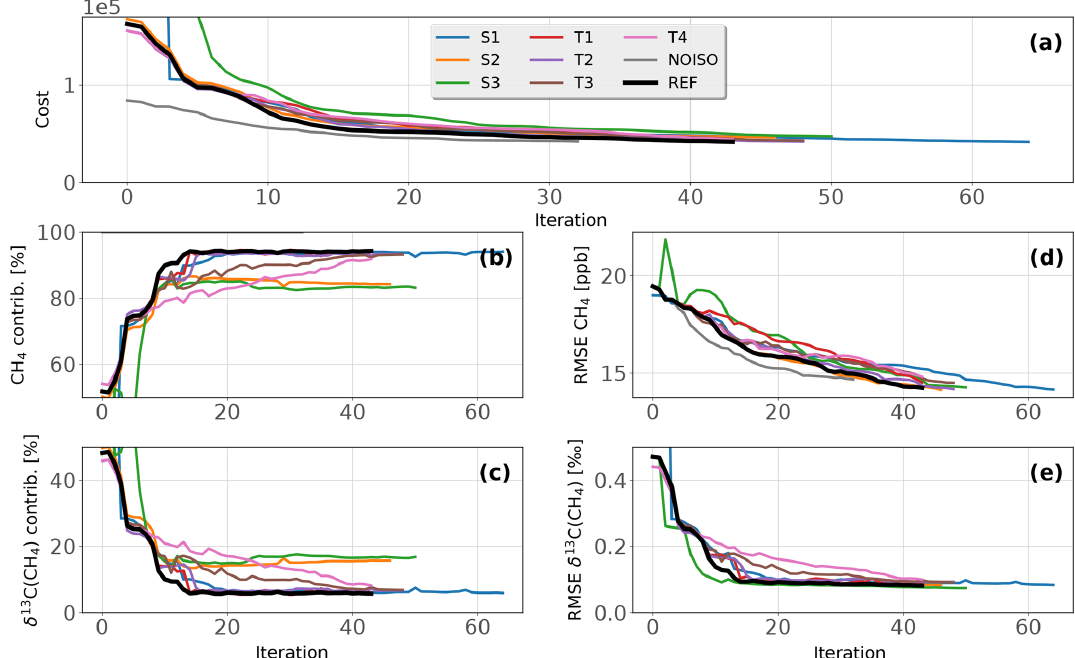
Figure 3. Minimization of the cost function for all configurations. (a) Value of the cost function with respect to the number of iterations. (b) CH 4 contribution to J o . (c) δ 13 C ( CH 4 ) contribution to J o . (d) RMSE associated to observed–simulated CH 4 . (e) RMSE associated to observed–simulated δ 13 C ( CH 4 ) . For clarity reasons, S1 and S3 initial values are not displayed because they are much larger than those of